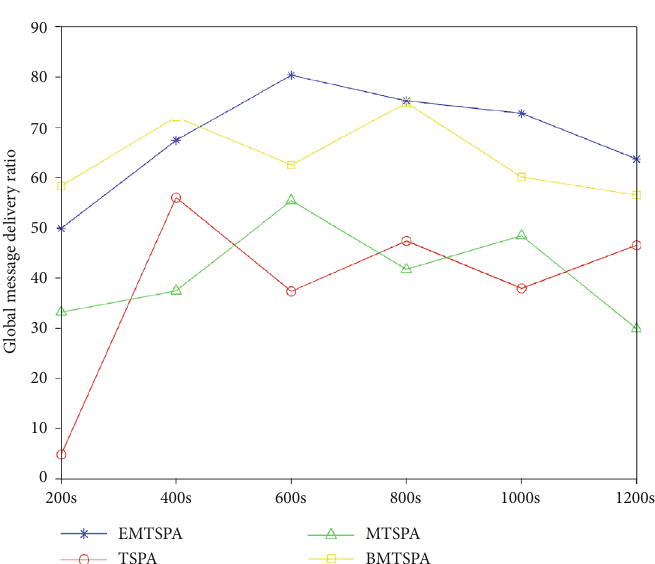
Figure 11: Comparison of EF.